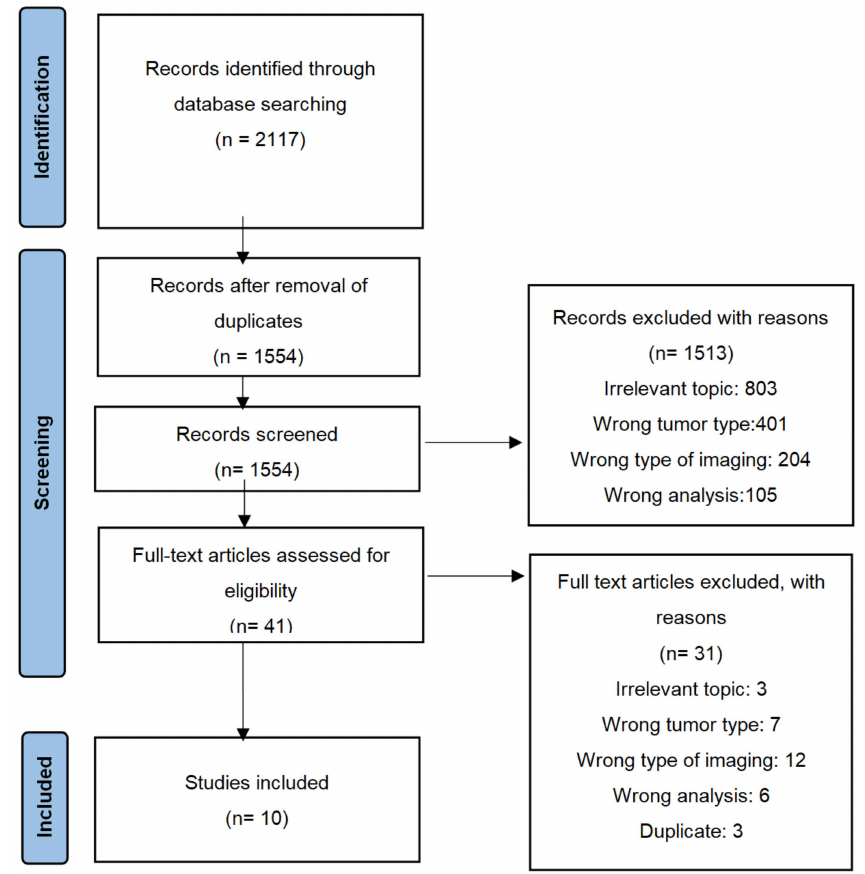
Figure 2. PRISMA flow